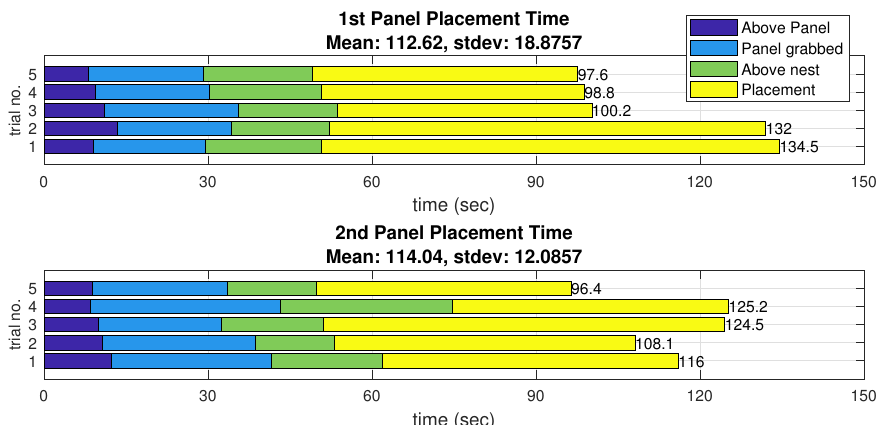
Figure 14. Timing data of end-to-end process of assembling two panels shows the most amount of time is spent at placement in order to achieve the required